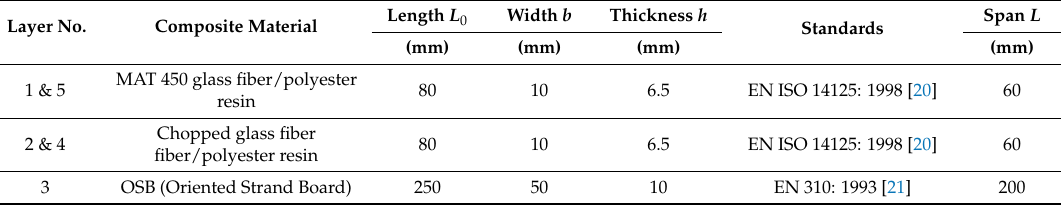
Table 1. The dimensions of the bending specimens, corresponding standards and span.